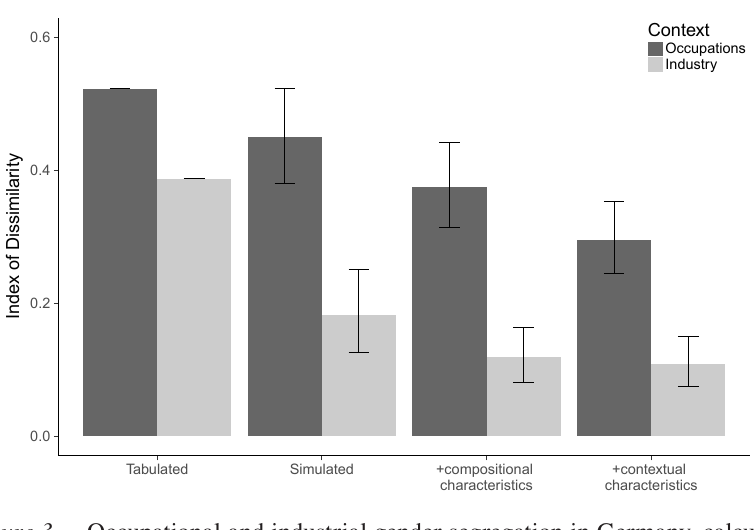
Figure 3 Occupational and industrial gender segregation in Germany, calculat- ed based on tabulated data and using cross-classified multilevel bino- mial response